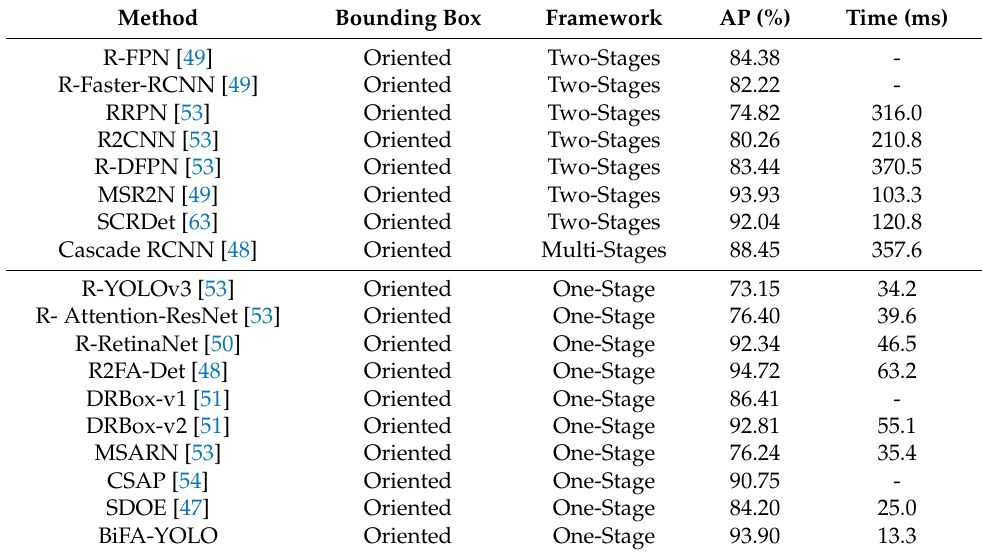
Table 10. Detection results of different CNN-based methods on